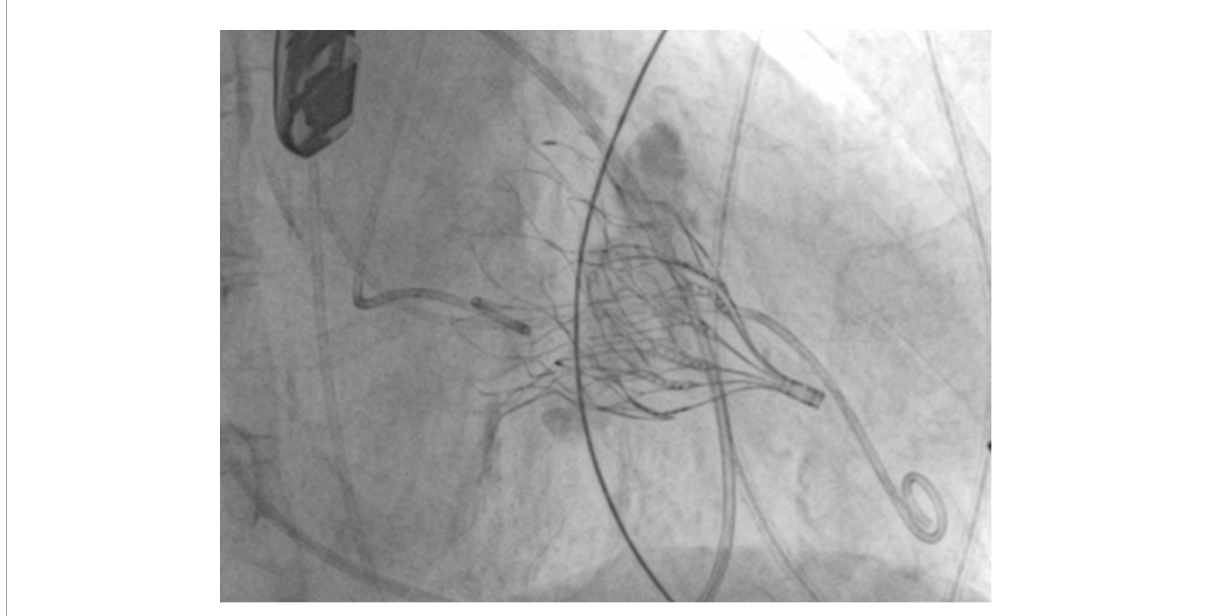
Frontiers in Cardiovascular